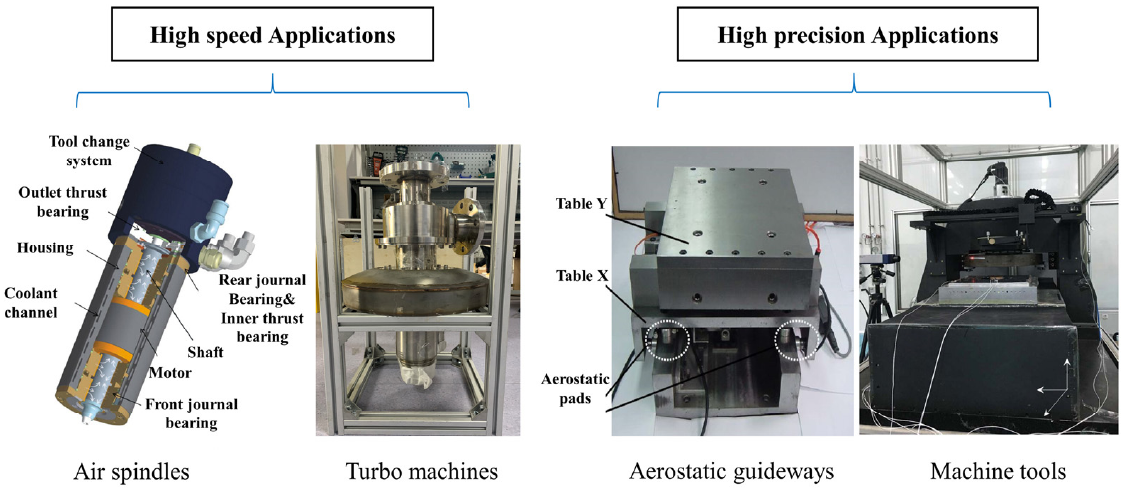
Figure 2. Applications of aerostatic thrust bearings [3–5,7].